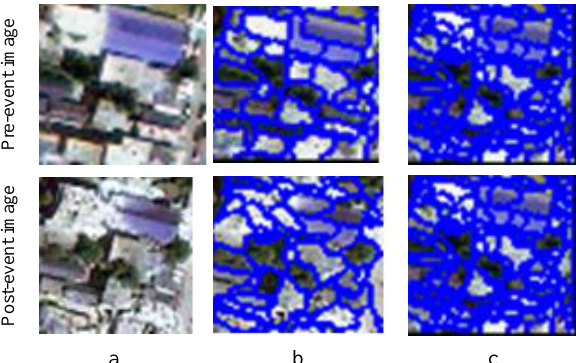
Figure 5: Segmentation intersection results of a sample are. a) pre- and post-event sample area. b) Obtained image objects from multiresolution segmentation technique. c)